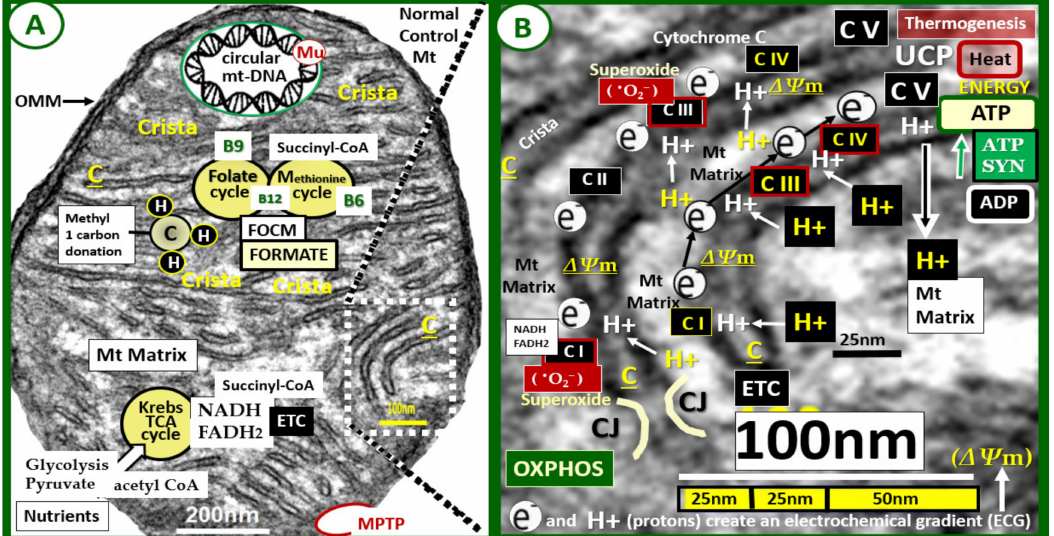
Figure 1. Normal mighty mitochondria (Mt). These images demonstrate the normal electron trans- port chain (ETC) and adenosine triphosphate (ATP) production in a 20-week-old healthy, control C57BL/6J female mouse model. Panel A demonstrates an exploded image of a normal mitochon- drion with its numerous cristae (C) (invaginations of the inner membrane to increase its surface area). Note the Krebs—TCA cycle lower-left that utilizes acetyl CoA from either glycolysis or fatty acid metabolism and importantly donates NADH and FADH2 to enter the electron transport chain (ETC) at complex I (CI) in panel B . Additionally, note the folate and methionine cycles representing the Mt folate-mediated one-carbon metabolism (FOCM) with their essential vitamin cofactors B12, B9, and B6. Importantly, formate is supplied to the nucleus via FOCM as well as succinyl-CoA from the methionine cycle (M) and also donates methyl groups to mtDNA, and nuclear DNA for maintenance and repair. Importantly, note that mitochondria have their own circular DNA that is capable of undergoing mutation(s) (Mu). Additionally, note the presence of a mitochondria per- meability transition pore (MPTP) lower-right in red coloring. Panel B is an exploded image of the boxed-in (white dashed lines) in panel A , which depicts an even higher exploded magnification (scale bar 100 nm) to improve the clarity of the Mt inner membrane cristae structures and the ETC. Note the movement or flow of electrons (e − ) from complex I to complex IV and hydrogen protons (H + ), which create the mitochondrial membrane potential ( ∆Ψ m) generated by the proton-pumping action from the matrix to the inner membrane space at complexes I, III, and IV. This results in the formation of ATP (energy) at complex V as protons (H + ) flow back into the Mt matrix through complex V resulting in the subsequent formation of ATP (energy) at complex V via the ADP sub- strate and ATP SYN [8]. The ETC may become overwhelmed when there is nutrient excess, such as occurs in hyperglycemia and hyperlipidemia associated with obesity and T2DM. Additionally, uncoupling protein(s) (UCPs), located on the inner Mt membrane are known to uncouple oxygen consumption by the respiratory chain from ATP synthesis, and it should be noted that thermogenesis (non-shivering) upper-right occurs in brown adipose tissue mitochondria that stain positive for uncoupling protein1 (UCP1) [8]. Original magnification × 12,000 and scale bars = 200 nm ( panel A ) and 100 nm ( panel B ). ADP = adenosine diphosphate; ATP SYN = adenosine triphosphate synthase; C = complex; CJ = crista junction; CoA = coenzyme A; FADH2 = reduced flavin adenine dinucleotide; NADH = reduced nicotinamide adenine dinucleotide; OMM = outer mitochondrial membrane; • O − = superoxide; OXPHOS = oxidative phosphorylation; TCA = tricarboxylic 2